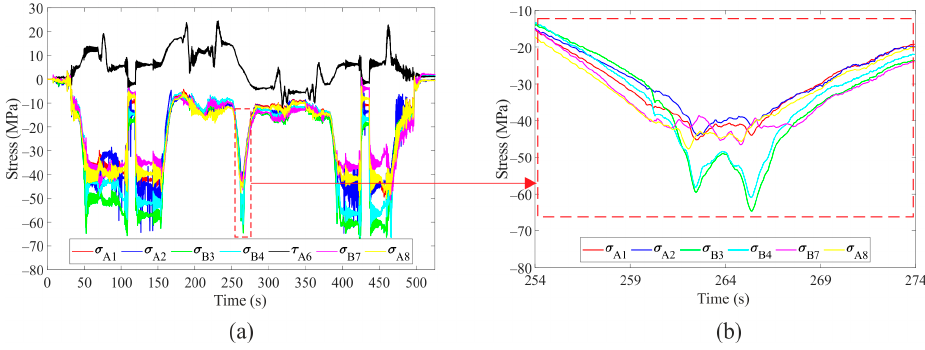
Figure 5. Time courses of stresses, Mode 3; coil 6: ( a ) full record, ( b ) detail record for the crab passing through the center of the girders.